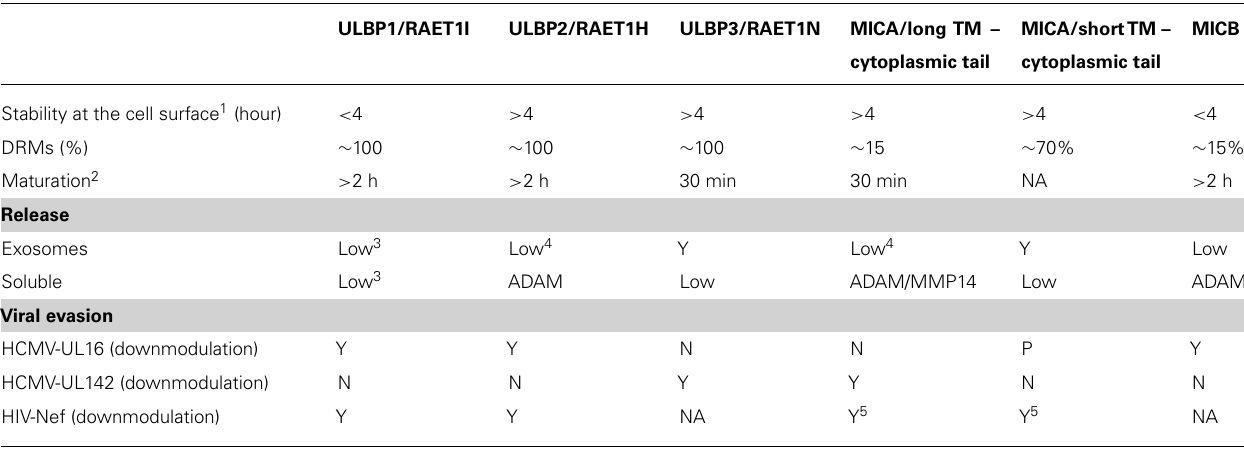
Table 1 | NKG2D-ligand biochemistry and cell